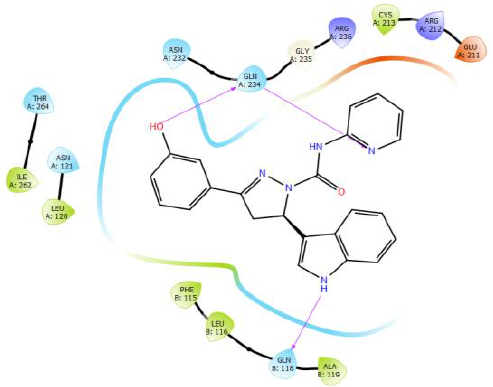
Figure 4. H-bonding interactions of compound after 4 h with the binding site residues.